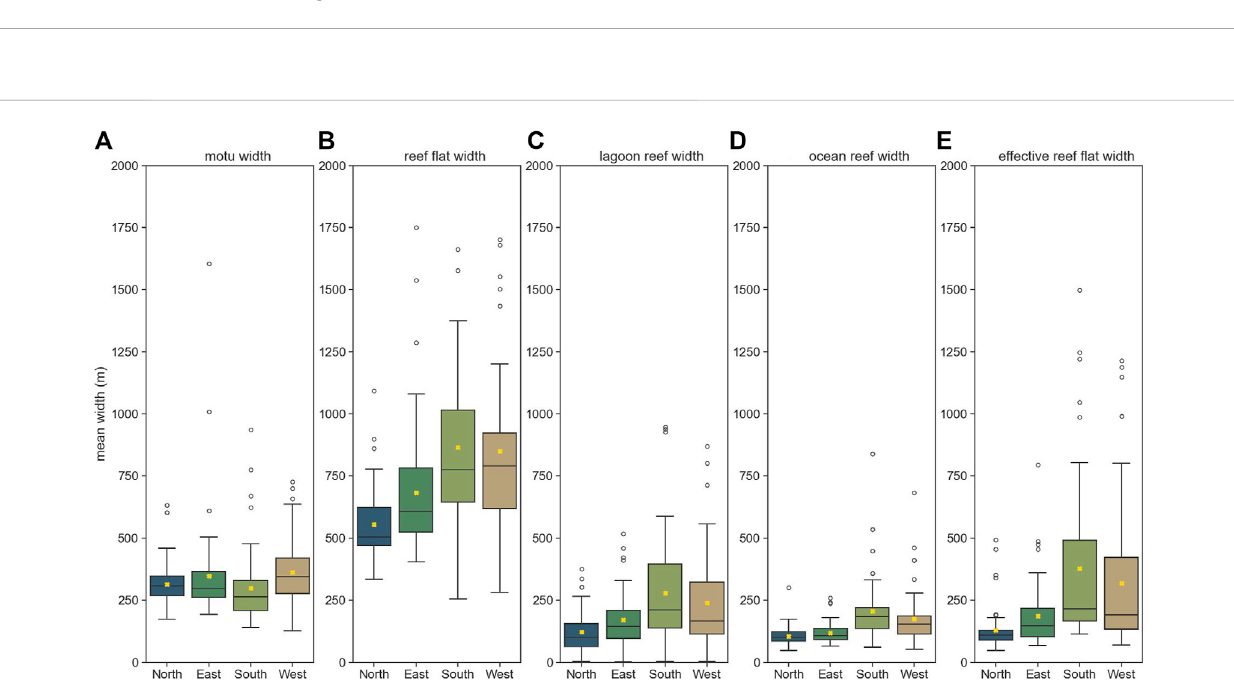
FIGURE 5 Cardinal position within the atoll binned widths in French Polynesia on a per-atoll basis for (A) motu width, (B) reef fl at width, (C) lagoon reef width, (D) ocean reef width, and (E) effective reef fl at width. One point per atoll is the mean width. Mean value of data shown as yellow x in all subplots, central black line indicating median value. Not shown on total reef fl at width (B) , two outliers: one point at 2,790 m in the South bin and one at 2,320 m in the West